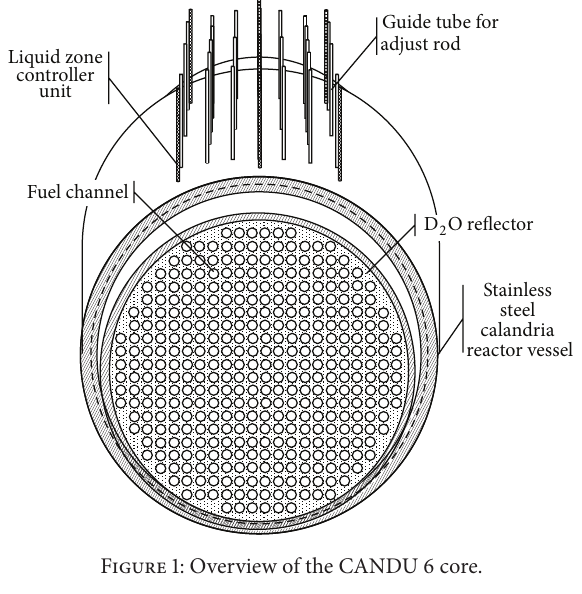
Figure 1: Overview of the CANDU 6 core.